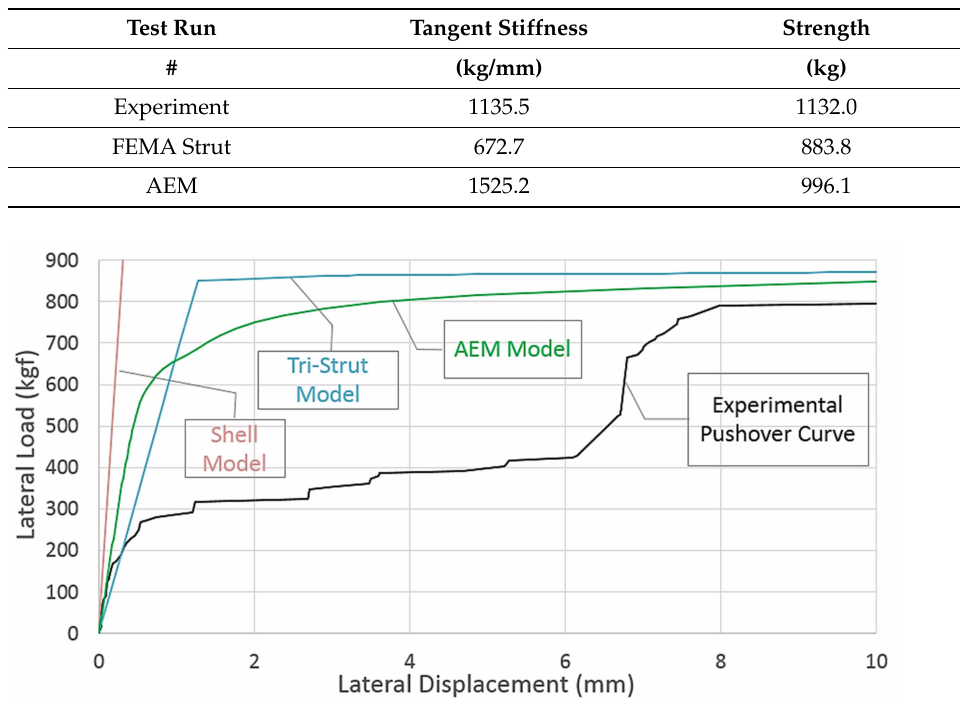
Figure 17. Comparison of experimentally obtained and predicted base shear vs top lateral displace- ments for scaled CM